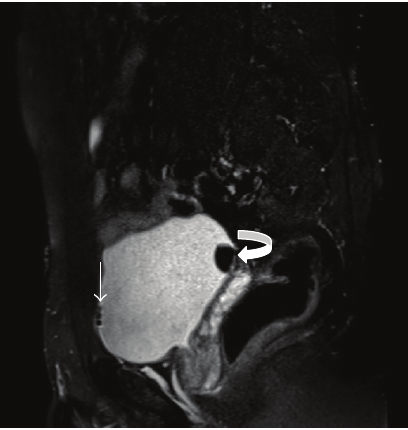
Figure 2: In MRI examination, there are hypointense air bubbles in anterosuperior part of bladder (arrow) and 2cm diameter of calculi in posterosuperior part of bladder at T2-weighted image (curved